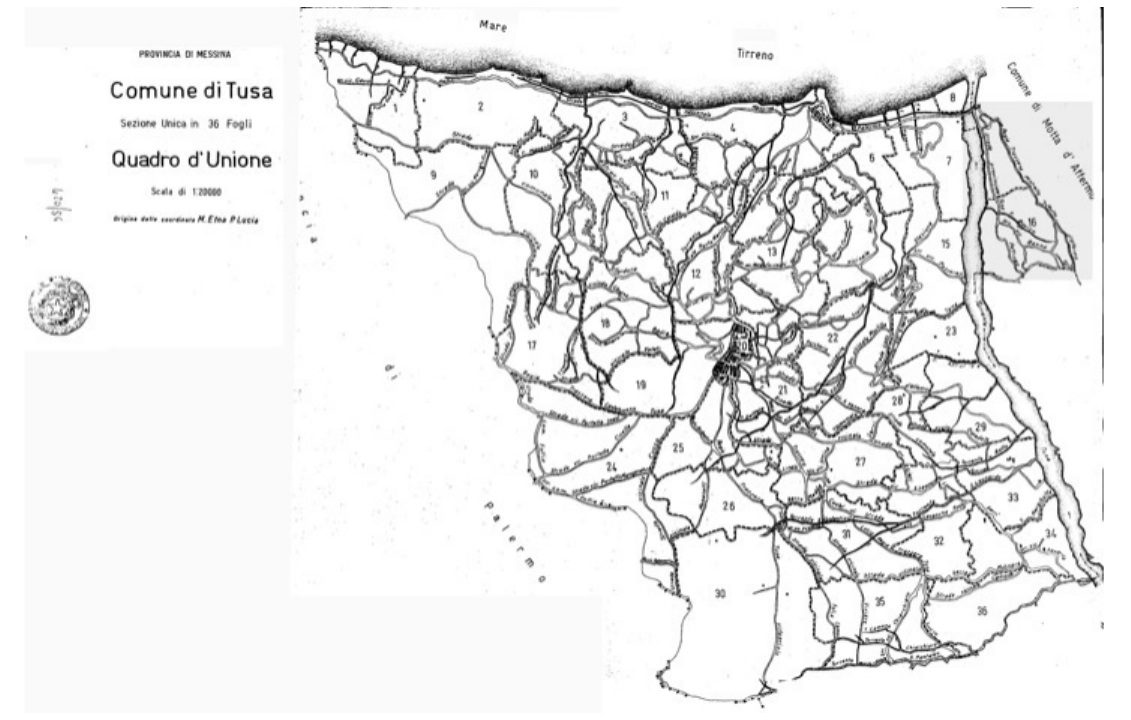
Figure 3. The Trazzera State Property Cadastral excerpt (source: Service 5—Management of State Forest, Trazzerale and Civic Uses). Table 1. Outline of the calculation of the sale price of the land parcels subject to the legitimation